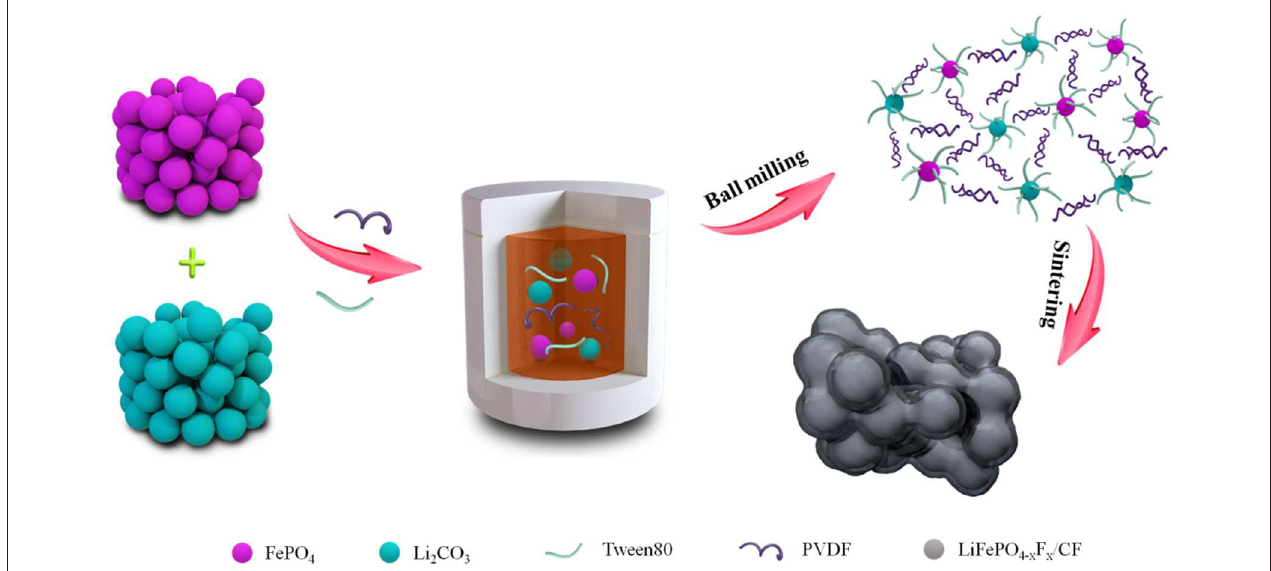
FIGURE 1 | (A) XRD pattern of LFP, LFP/C, and LFPF/CF composite, (B) Rietveld refinement plot of LFPF/CF, (C) Raman patterns of LFP, LFP/C, and LFPF/CF composite, and (D) The crystal structure of LFPF/CF composite.